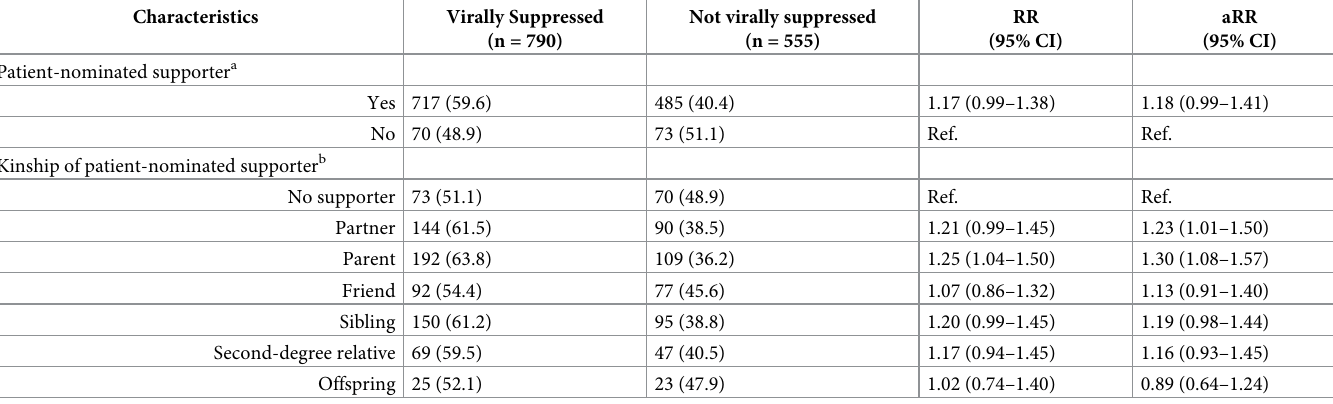
Table 5. Associations between having patient-nominated supporters and being virally suppressed among people living with HIV, 2011–2014.